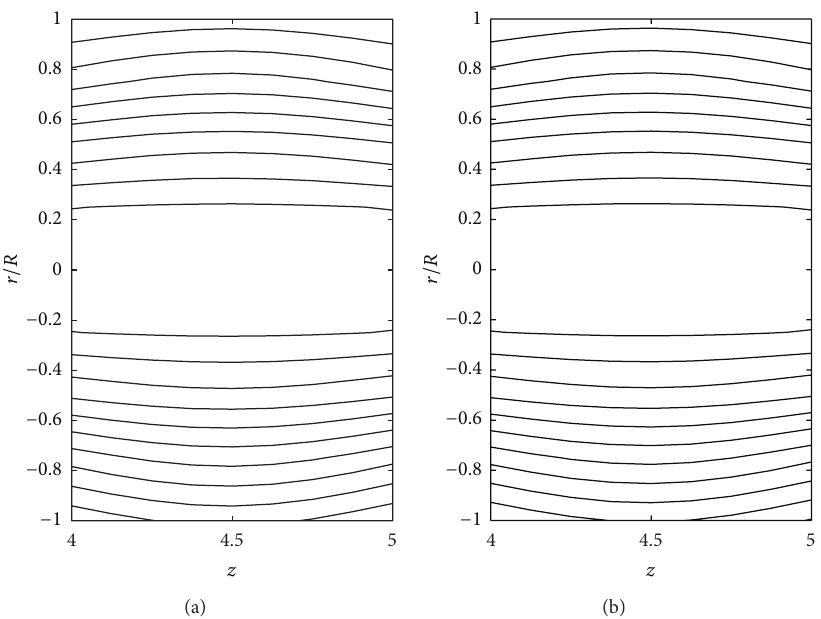
Figure 19: Stream lines for different values of 𝑘 : (a) 𝑘 = 1 and (b) 𝑘 = 1.2 taking 𝑛 = 0.8 , 𝜏 𝑦 = 0.1 , 𝛿 2 = −0.2 , and 𝜁 = 0.01 in the dilatation